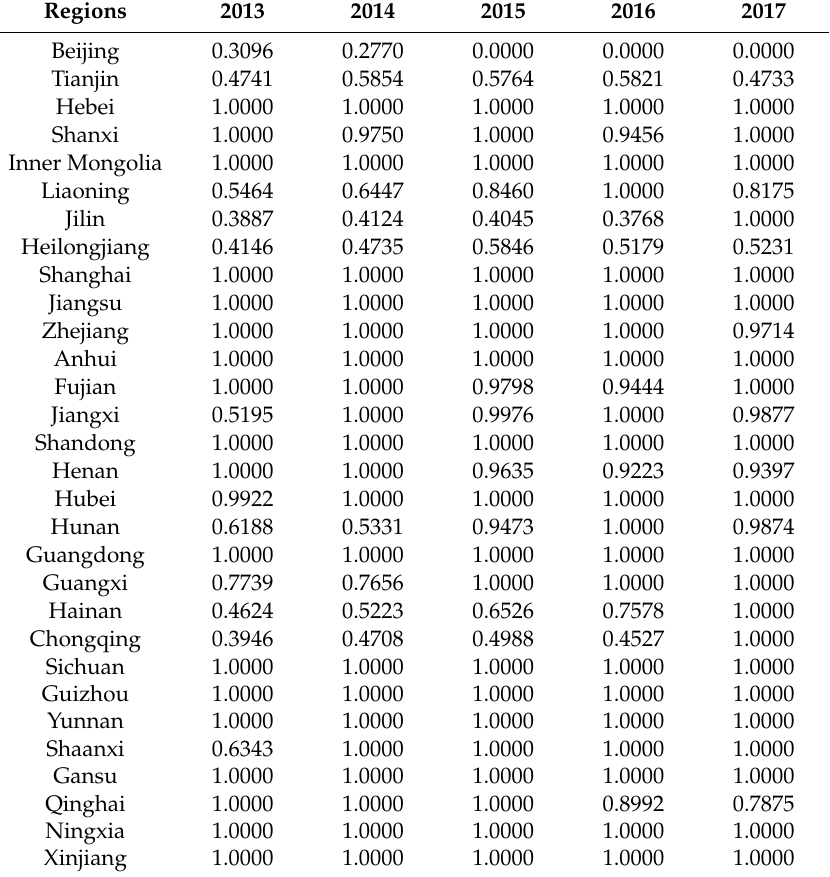
Table 4. E ffi ciencies calculated by the CCR–DEA